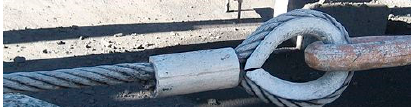
Figure 53. Devices used to fasten the loose ends of the steel wire ropes together, in the second combined technique: ( a ) overview of the sequence of devices, consisting of an eye-eye turnbuckle in the middle and a series of two clips, one ferrule, and one thimble on both sides. ( b ) How to install the clips, with the saddle portion of the clamp assembly placed against the “live” end. The function of the flat bearing seat and extended prongs of a clip (saddle) is to protect the live or stress-bearing end of the rope against crushing and abuse. Therefore, when installing clips, the saddle portion of the clamp assembly is placed against the load bearing or “live” end (Figure 53b), not against the non-load-bearing or “dead” side of the cable. The number of clamps needed to terminate a wire rope, usually three or more, depends on the diameter of the wire rope. To choose the correct number of clamps for the second combined technique, the authors tested assemblies with three clamps (one ferrule and two clips, as in Figure 53a) and assemblies with two clamps (two clips, as in Figure 53b), finding the latter more performing for a 3 mm single strand zinc-coated wire rope. The Flemish eyes of the second combined technique pass through the threaded eyebolts of a turnbuckle (Figure 53a). By rotating the metal frame of the eye-eye turnbuckle, it is possible to screw